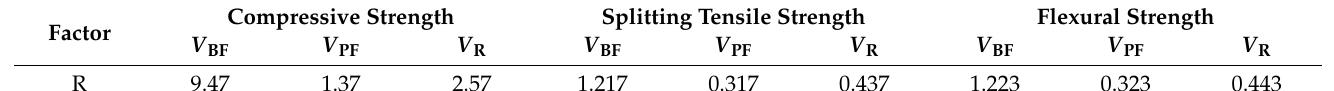
Table 5. Calculation results of the range of HFRC strength.